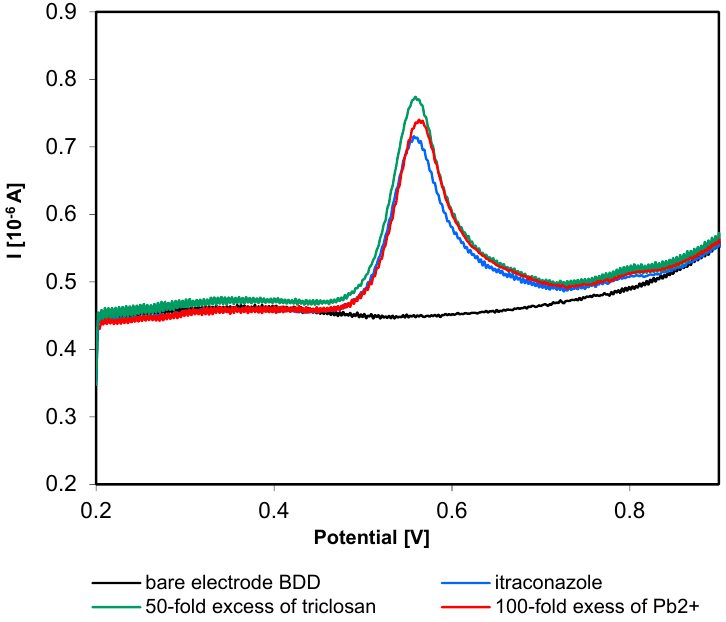
Figure 8. SWV voltammograms of itraconazole in B-R buffer pH 2.87 in the presents of selected interferents.